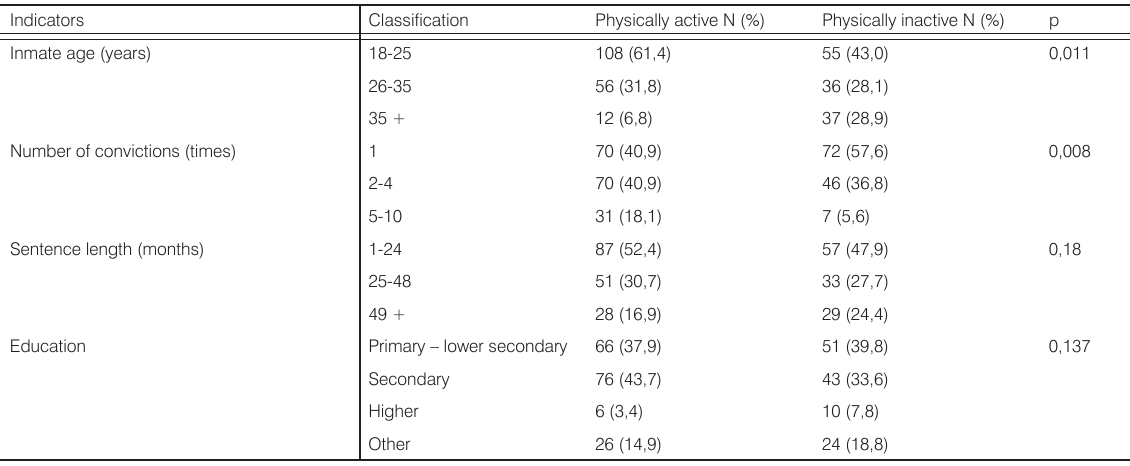
Table 1. Distribution of physically active and inactive inmates according to their age, number of convictions, sentence length and education (analyses performed on all respondents).